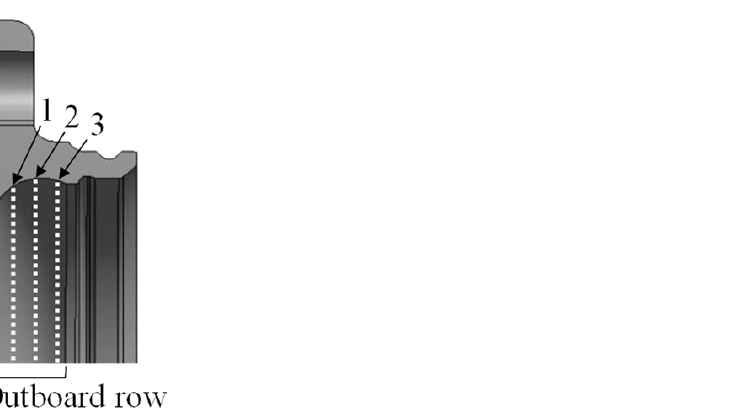
Figure 13. Analysis locations for the roundness of the outer ring raceway in inboard/outboard row.